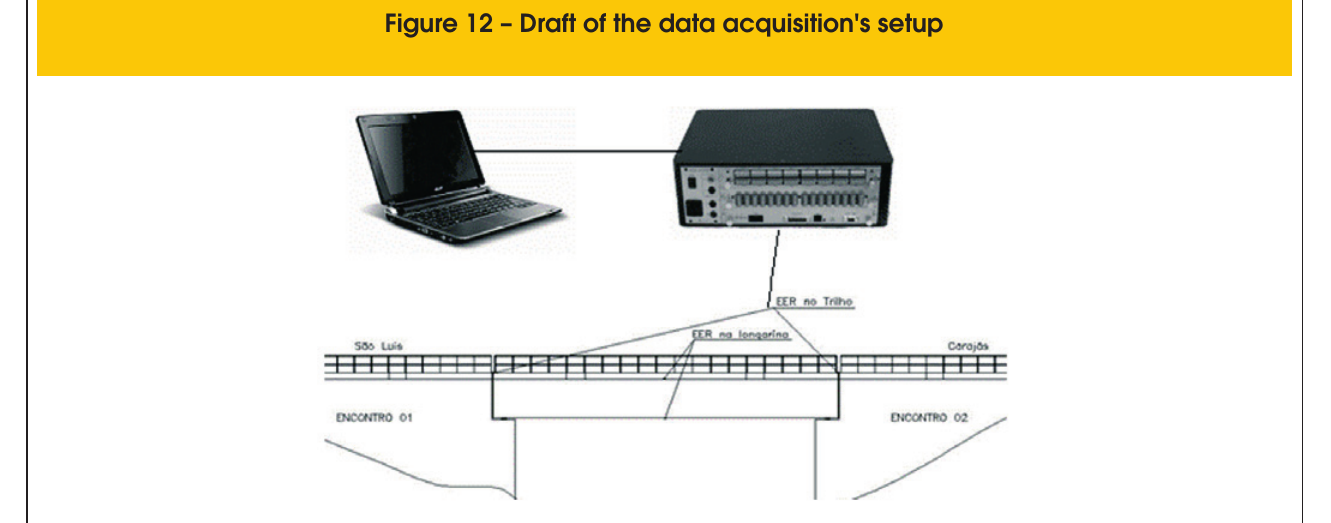
Figure 12 – Draft of the data acquisition's